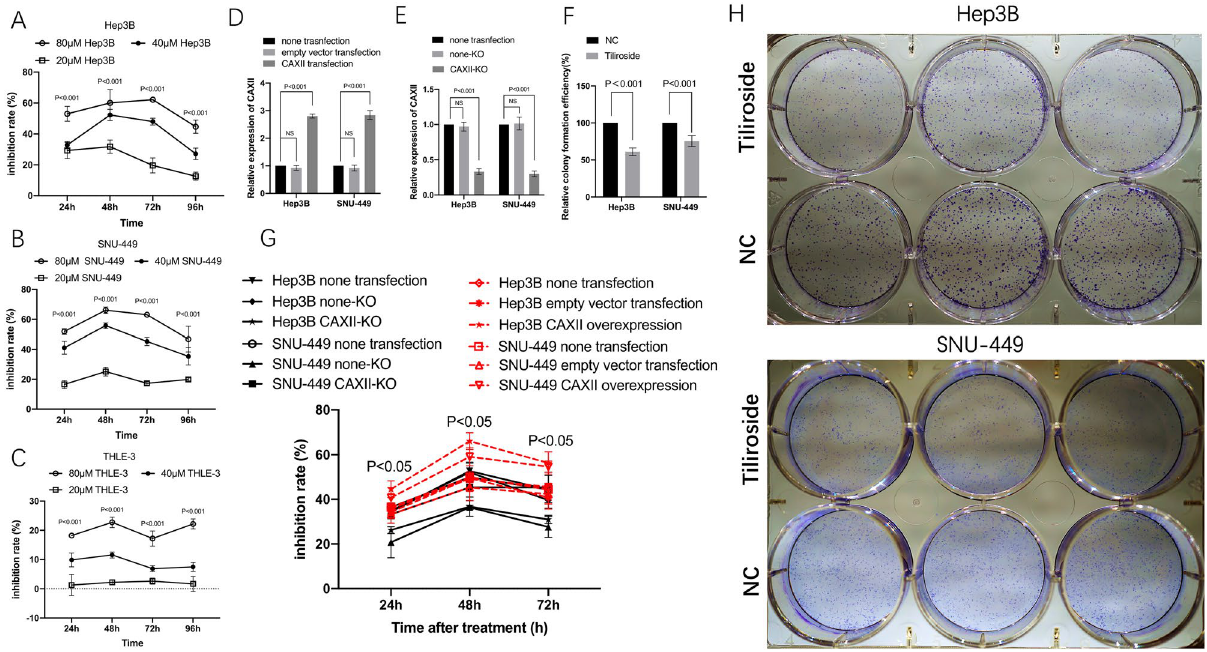
Figure 1. Tiliroside inhibited the proliferation and colony formation of Hep3B and SNU-449 cells and the restoration by CAXII overexpression. Relative inhibition rates of Hep3B, SNU-449 and also THLE-3 in response to different concentrations of Tiliroside were calculated by comparing the OD value of NC, at 24, 48, 72, and 96 h, respectively ( A – C ). The representative colony formation of Hep3B and SNU-449 cells intervened by 40 μM Tiliroside and NC ( H ). The relative colony formation efficiency showed significant reduction of colony 10 days after Tiliroside intervention in both Hep3B and SNU-449 cells ( F ). The relative CAXII expression was significantly higher in CAXII-transfection group than non-transfection group in both Hep3B and SNU-449 cell lines ( D ). The relative CAXII expression was significantly decreased in CAXII-KO group than none transfection group in both Hep3B and SNU-449 cell lines ( E ). The inhibition rates brought by Tiliroside were significantly increased in CAXII overexpression group compared to both non-transfection group and empty vector group, at 48 and 72 h, respectviely, in Hep3B and SNU-449 cells. On the contrary, The inhibition rates were significantly decreased in CAXII-KO group compared to both non-transfection group and none-KO group, at 24, 48